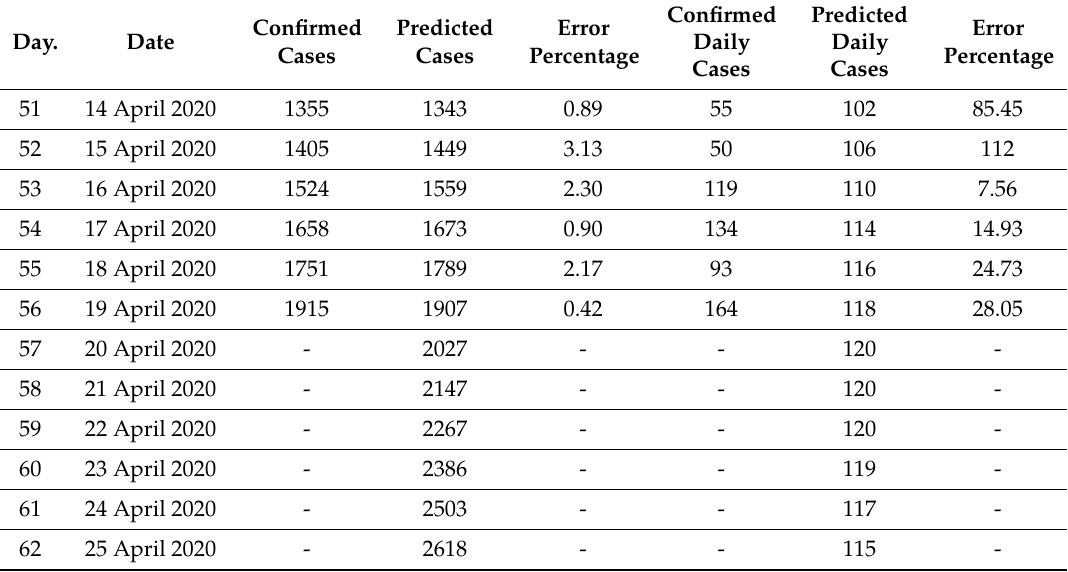
Table 4. Short term forecasting for